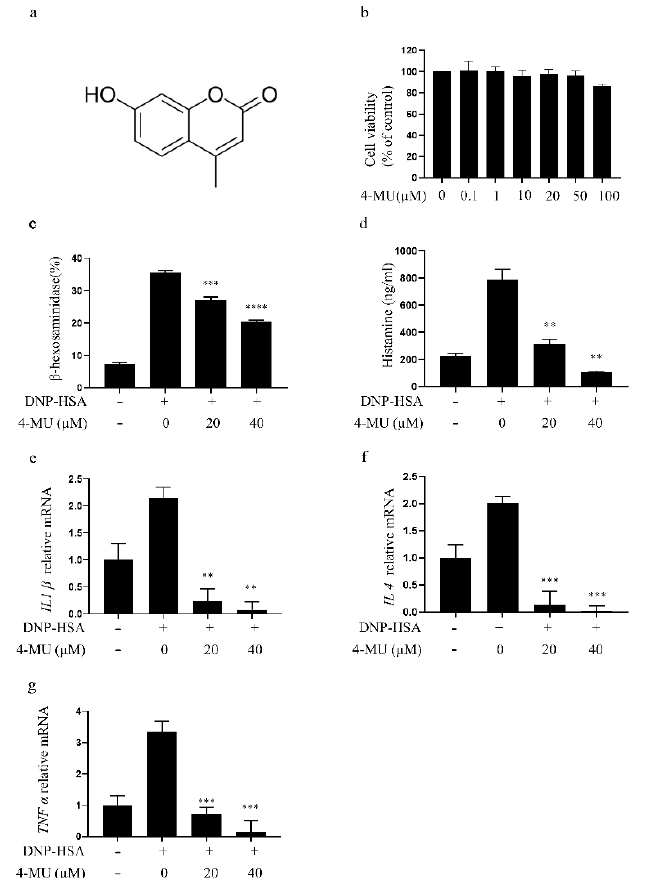
Figure 1. Treatment with 4-MU suppresses Fc ε RI-mediated degranulation in RBLs. ( a ) Chemical structure of 4-MU. ( b ) Viability of RBLs incubated with 0 –100 μM 4 -MU for 24 h determined by CCK-8 assays. ( c – g ) Secretion of β -hexosaminidase ( c ), histamine release ( d ), and expression of inflammatory cytokine genes IL1β ( e ), IL4 ( f ), and TNFα ( g ) in RBLs sensitized with anti-DNP IgE, with or without 4-MU, for 1 h, and then challenged with DNP-HSA. The data are shown in means ± SDs (five duplicate experiments); ** p < 0.01, *** p < 0.001, **** p < 0.0001 vs. non-treated activated cells. 4-MU, 4-methylumbelliferone; DNP-HSA, dinitrophenyl-human serum albumin protein conjugate; RBL, RBL-2H3 cell.